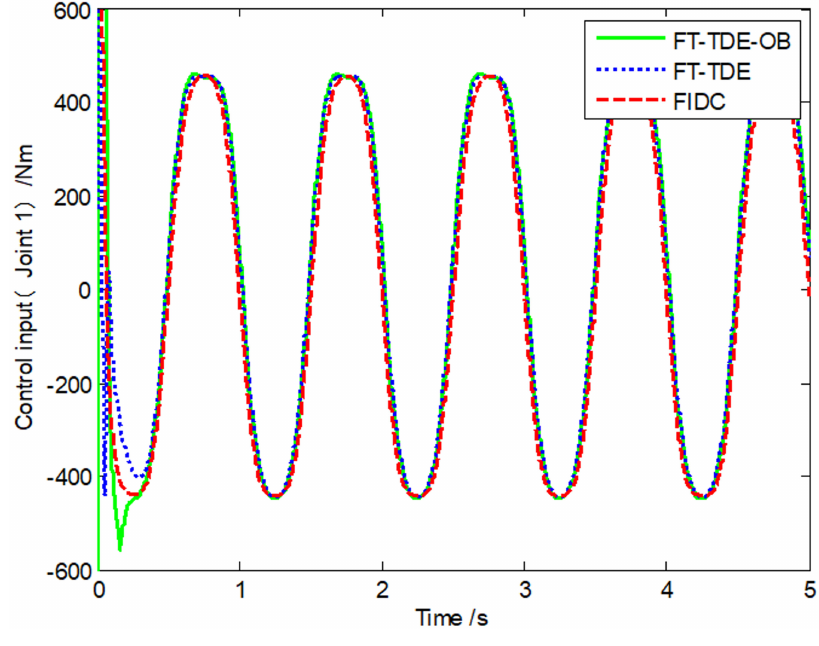
Figure 7. Control input of Joint 1.